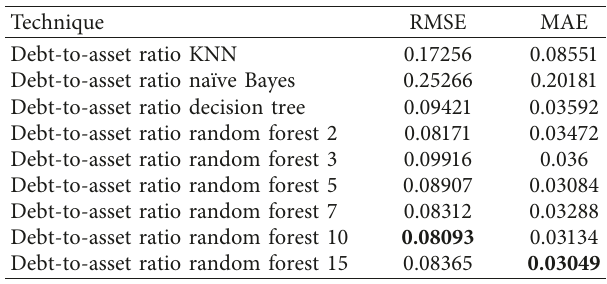
Table 1: Error measurement using KNN, na¨ıve Bayes, decision tree, and random forest.